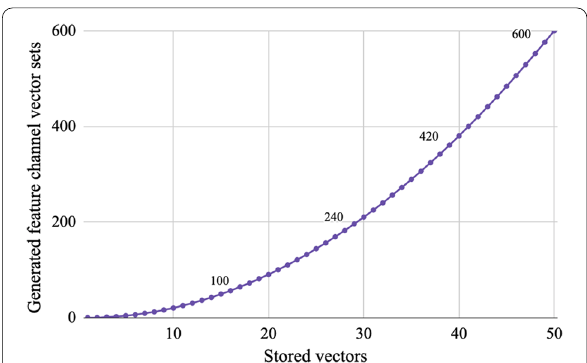
Fig. 7 Number of unique feature channel vector sets {iM, PFP, NFP} that can be generated, and hence the number of channels that